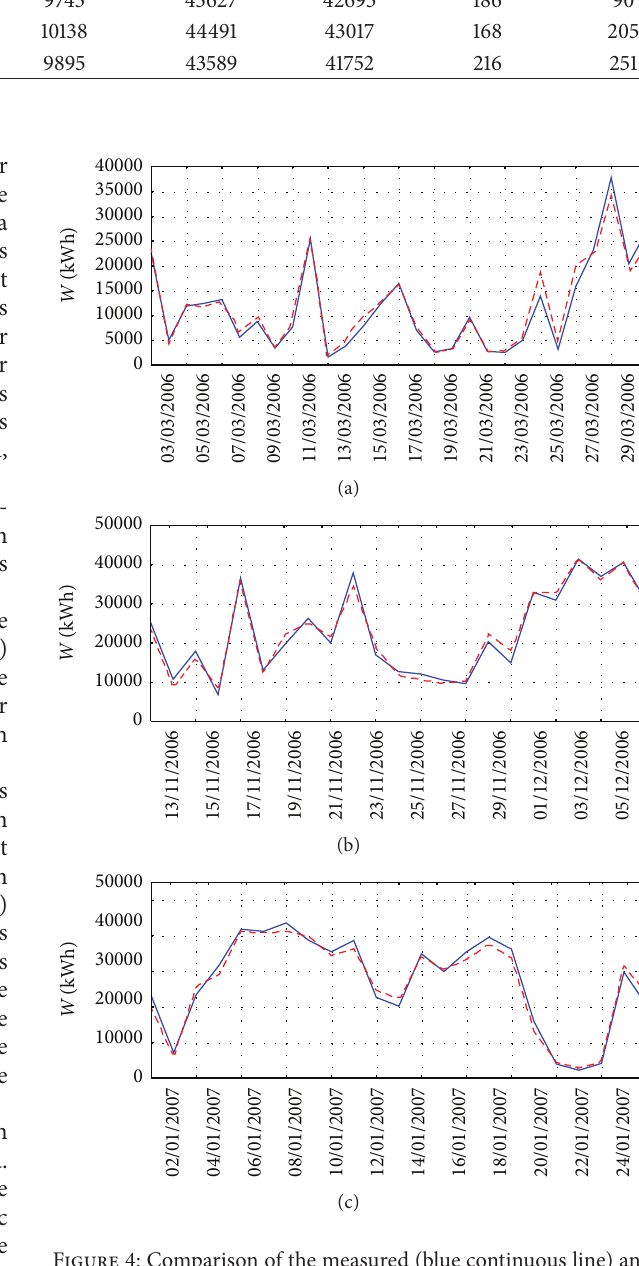
Figure 4: Comparison of the measured (blue continuous line) and network reproduced (red dashed line) daily energy values of the turbines at the coastal